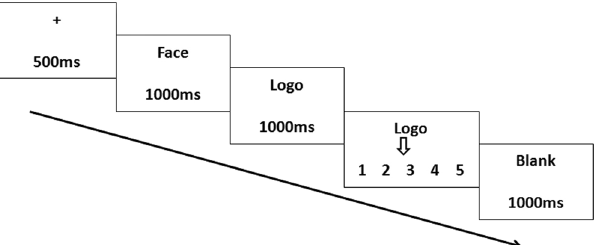
Figure 4. A single trial of the procedure of experiment 1. Participants saw an attractive face or an unattractive face at first then ranked the preference degree of the following logo using a provided